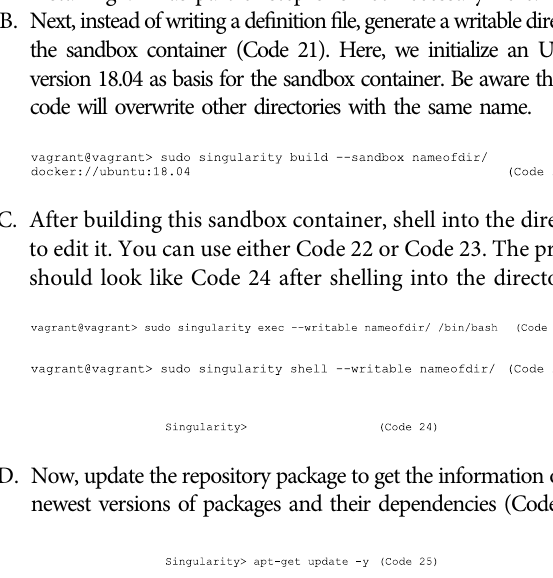
( Figure 2 ). For this, you need a SLURM fi le to submit a job to the cluster. This fi le should contain all required SLURM parameters, including parameters for job name, number of nodes, memory requirements and time limit. In addition, the SLURM fi le should load Singularity and run the container on selected images (c.f. Supplementary Files, github). Copy the SLURM fi le and the container to a folder on the cluster and go to this folder on the cluster. Now, run the container by calling the SLURM fi le (Code